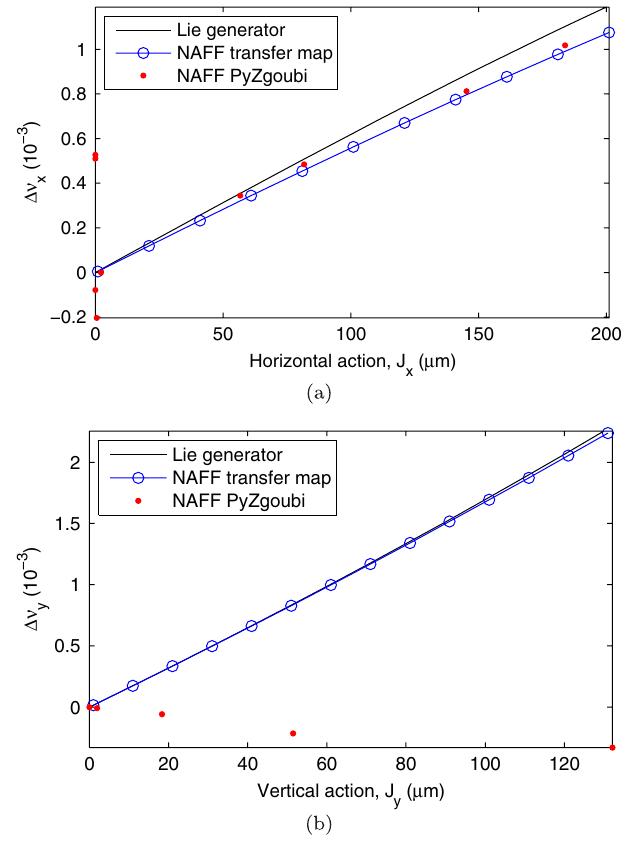
FIG. 10. Change in (a) the horizontal tune with the horizontal , and (b) the vertical tune with vertical action J action J x reference energy 19 MeV. The black line shows the tune shift calculated from the transfer map using normal form analysis; the blue circles show the tune shift from NAFF of tracking results (using the transfer map in Taylor form); and the red points show the tune shift from NAFF of numerical tracking results (using PYZGOUBI ). The discrepancy in the vertical plane between PYZGOUBI and the other codes is likely due to the different magnetic field representation used in PYZGOUBI